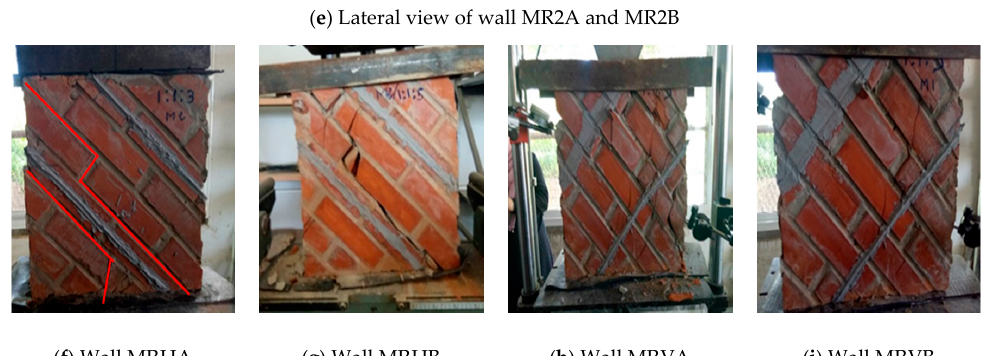
Figure 7. Failure modes of all reinforced masonry walls.